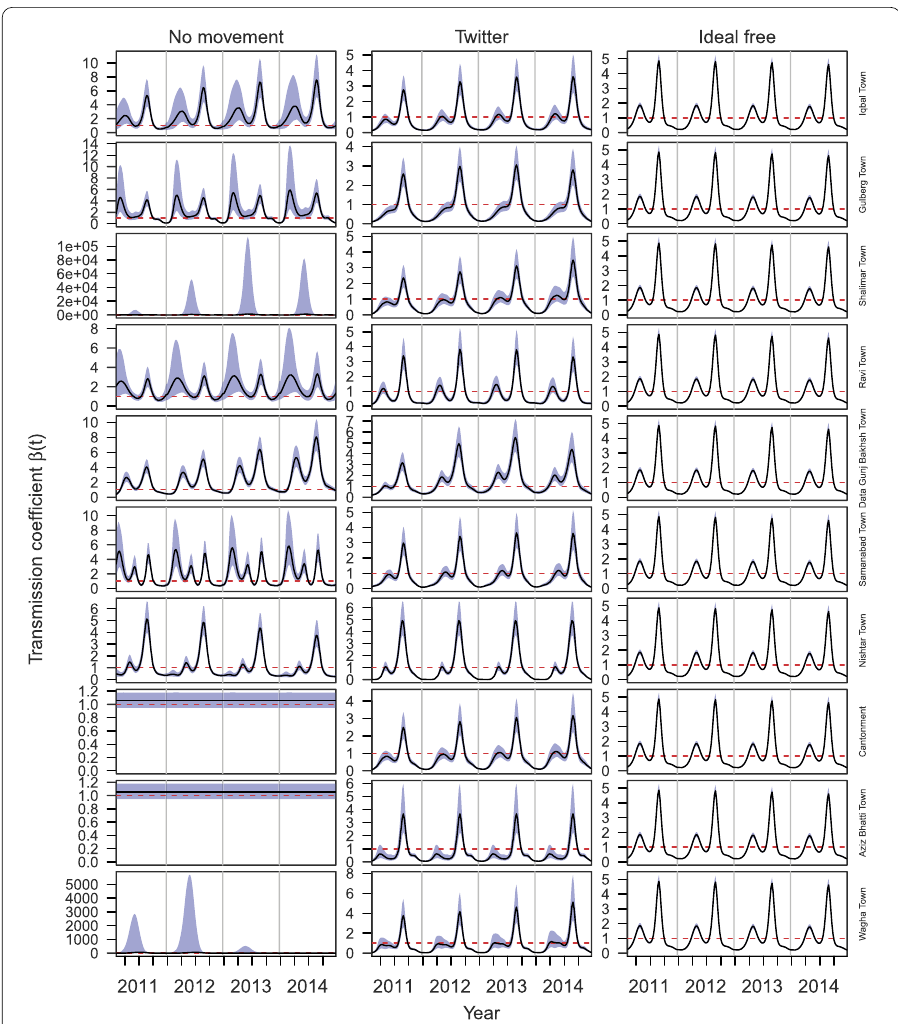
Figure 6 Temporal variation in β i ( t ) for different towns (rows) under three different mobility assumptions (columns): no movement (left), Twitter (center), and ideal free (right). The black line shows the mean of the best-fit model and blue bands show standard error around the mean. The dashed red line indicates where β i ( t ) =